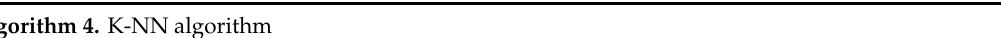
Algorithm 4. K-NN